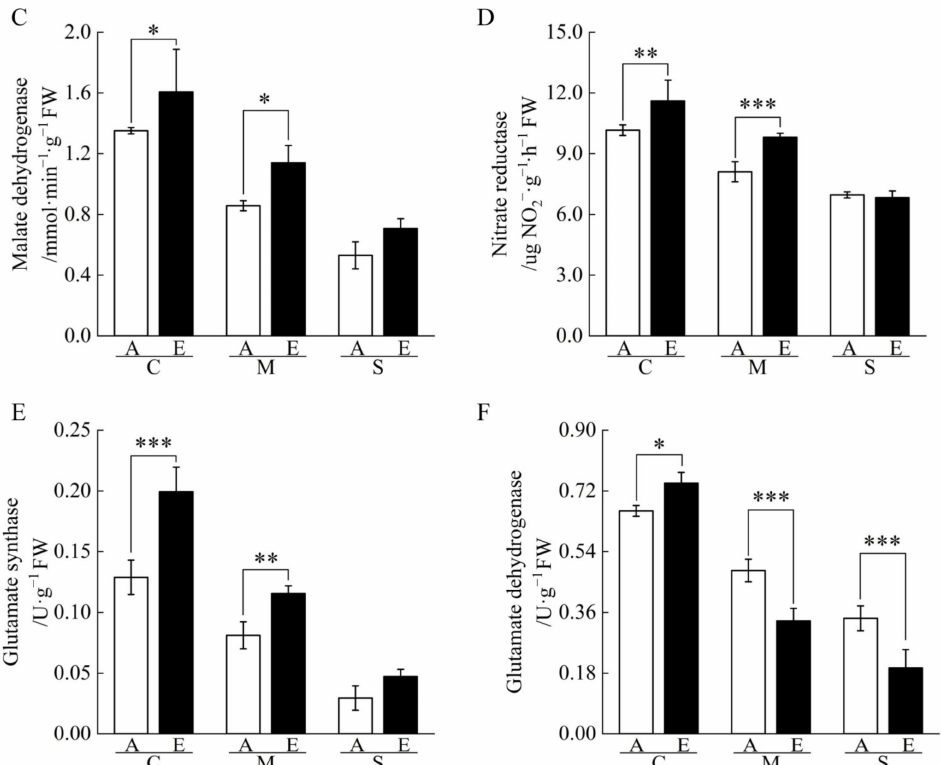
Figure 4. Effects of [CO 2 ] enrichment on the activities of related enzymes in roots of cucumber seedlings under drought stress. ( A ) Hexokinase, ( B ) Alcohol dehydrogenase, ( C ) Malate dehydroge- nase, ( D ) Nitrate reductase, ( E ) Glutamate synthase, ( F ) Glutamate dehydrogenase. All results are expressed as the mean ± standard deviation (SD) of three repeated values; *, difference is signifi- cant at the 0.05 level; **, difference is significant at the 0.01 level; ***, difference is significant at the 0.001